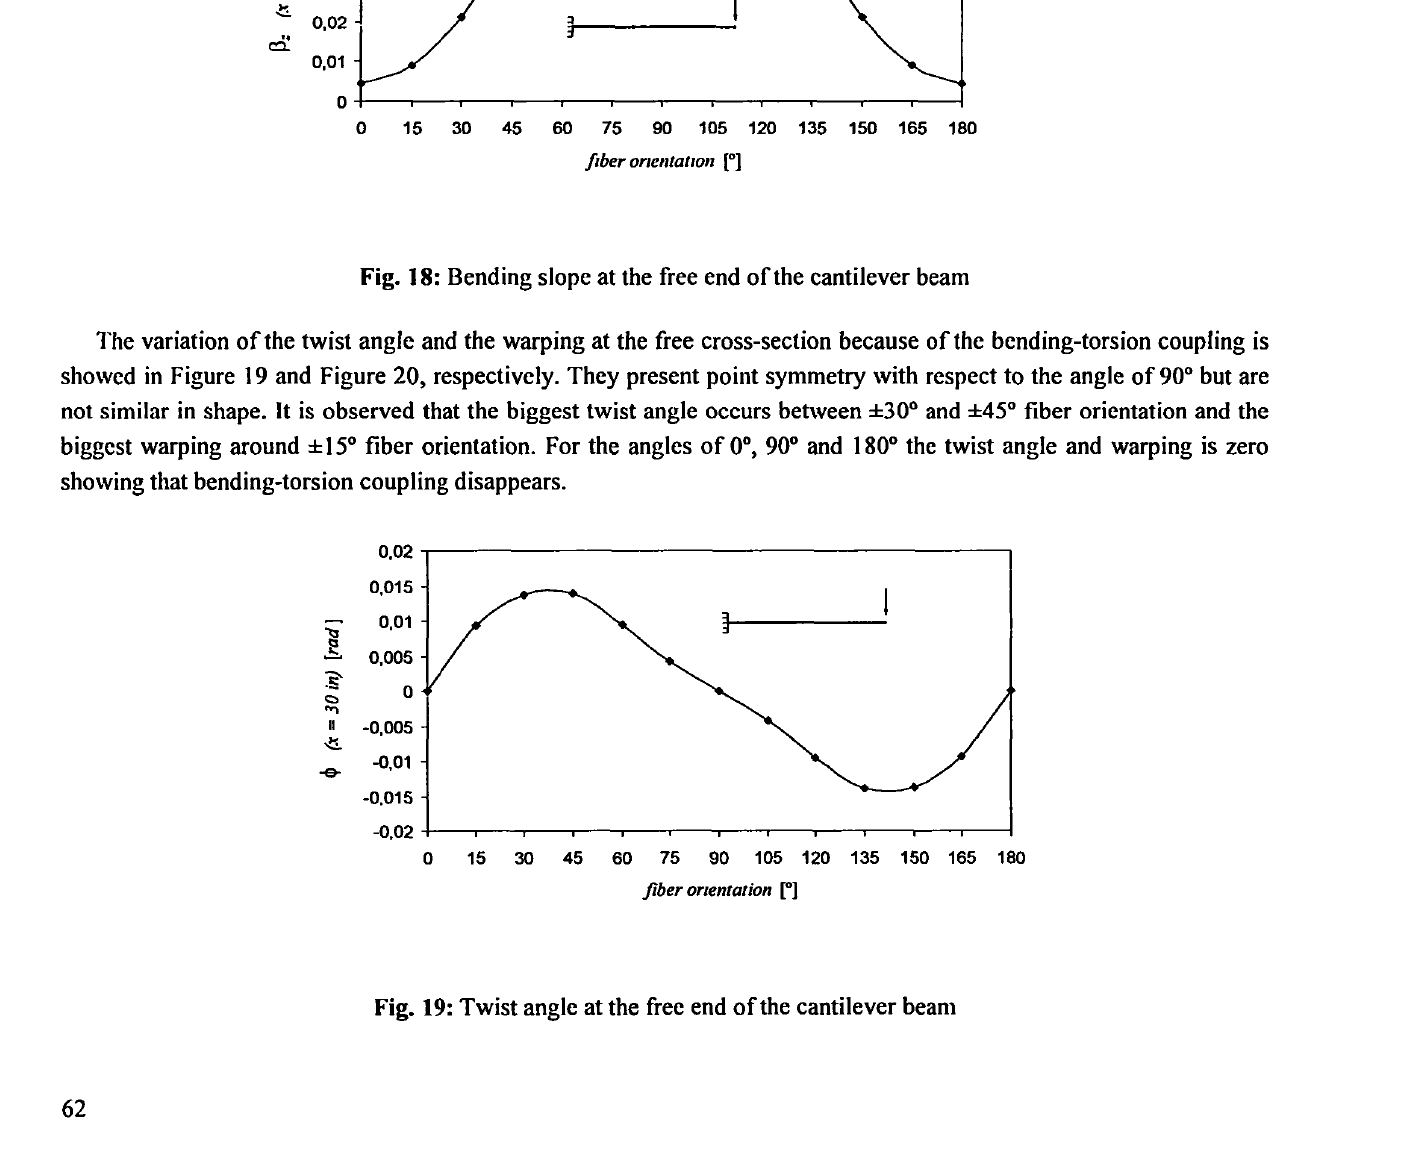
Fig. 19: Twist angle at the free end of the cantilever